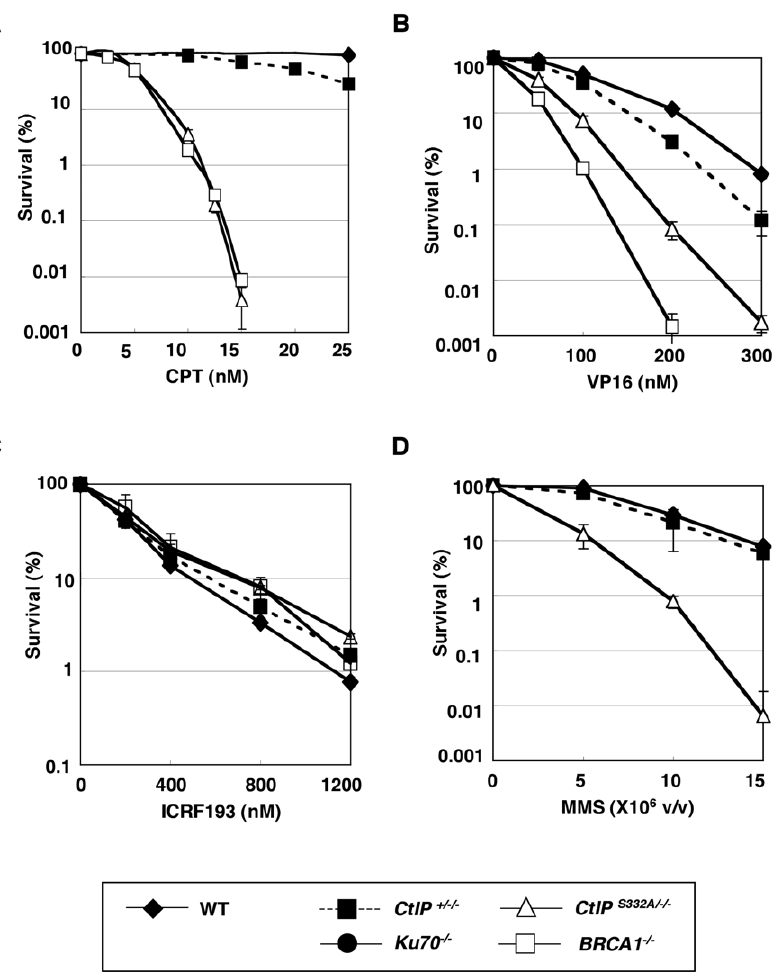
Figure 5. Colony survival assay of CtIP mutant cells to various genotoxic agents. Colony survival assay of asynchronous populations of cells exposed to (A) camptothecin (CPT), (B) etoposide (VP16), (C) ICRF-193, and (D) methyl methanesulfonate (MMS). The dose is displayed on the X axis on a linear scale, while the percent fraction of surviving colonies is displayed on the Y axis on a logarithmic scale. To count the surviving colonies, cells were grown for 8–10 days in methylcellulose medium containing various concentrations of DNA–damaging agents. At least three independent experiments were performed with triplicate samples, and the representative results are shown. The error bars indicate S.D.